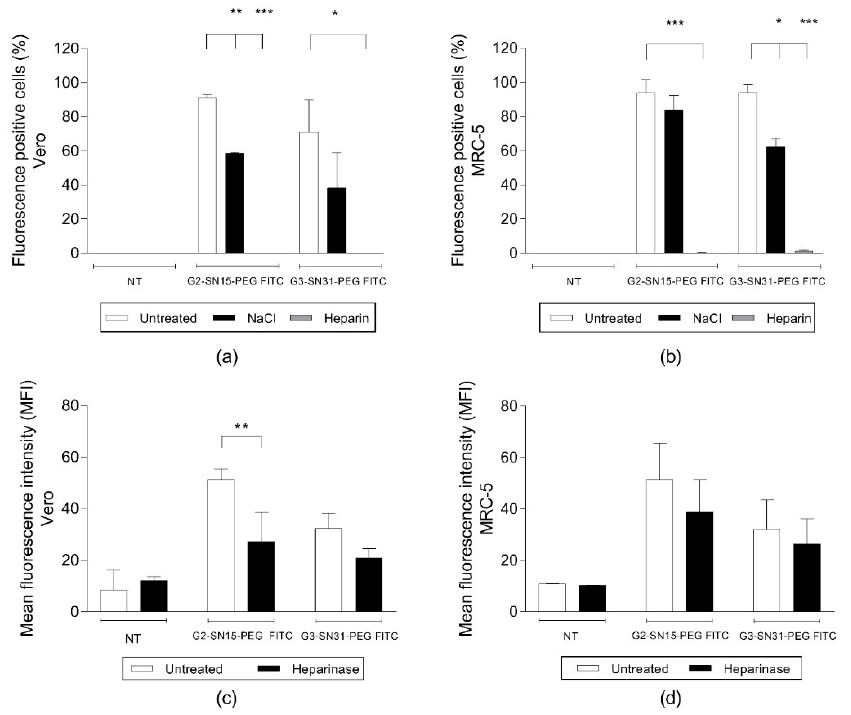
Figure 6. Interaction of cationic dendrimers with cell surface heparan sulphate proteoglycans (HSPGs). Fluorescent positive cells and mean fluorescence intensity of G2-SN15-PEG FITC and G3-SN31-PEG FITC dendrimers measured by flow cytometry in Vero ( a , c ) and MRC-5 ( b , d ) cells. Heparin competition assay, NaCl wash, and heparinase II treatment experiments were performed to determine the interaction of PEGylated cationic carbosilane dendrimers (PCCDs) with cell surface HSPGs. Data are represented as mean ± SD of two individual experiments * p < 0.05; ** p < 0.01; *** p < 0.001.